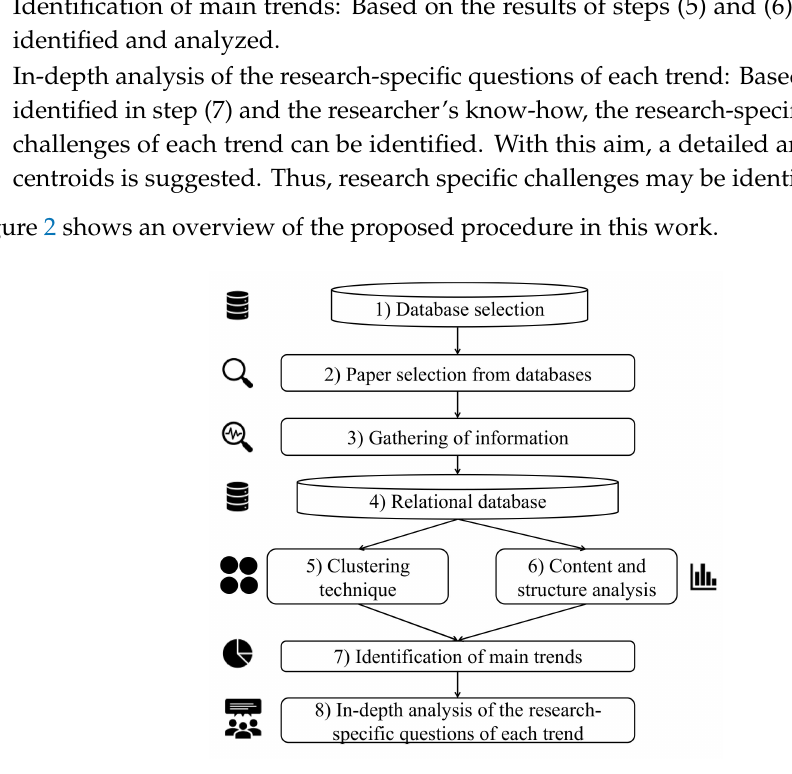
Figure 2. Overview of the proposed